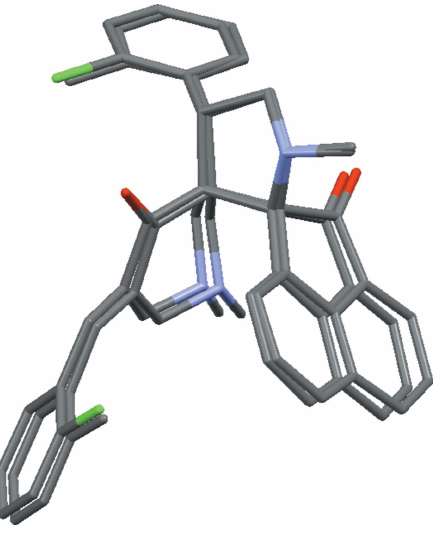
Figure 3 An overlay diagram depicting the superimposition of molecule (I) and (II) showing no differences in the conformations.